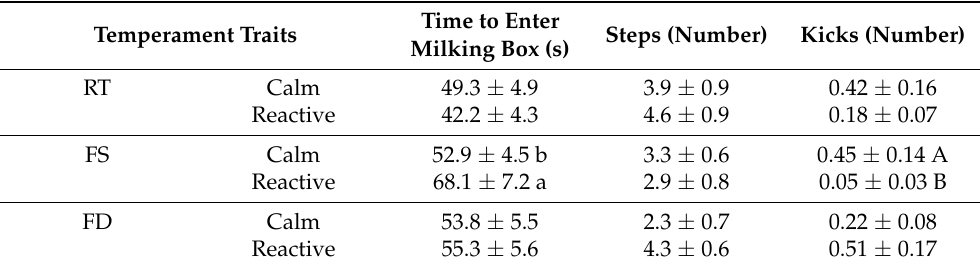
Figure 1. Number of kicks of multiparous Holstein cows during the first five milkings in the automatic milking system (AMS) according to flight distance test classes: calm cows (white) or reactive cows (black). Differences between milkings within each temperament class are indicated with different letters, and differences between temperament classes within the same milkings are indicated with * ( p ≤ 0.05). Table 2. Mean ± SEM for different milking behaviours by temperament (classified by race time (RT), flight speed (FS), and flight distance (FD)) of multiparous Holstein cows during the first five milkings in an automatic milking system, after changeover from a conventional milking